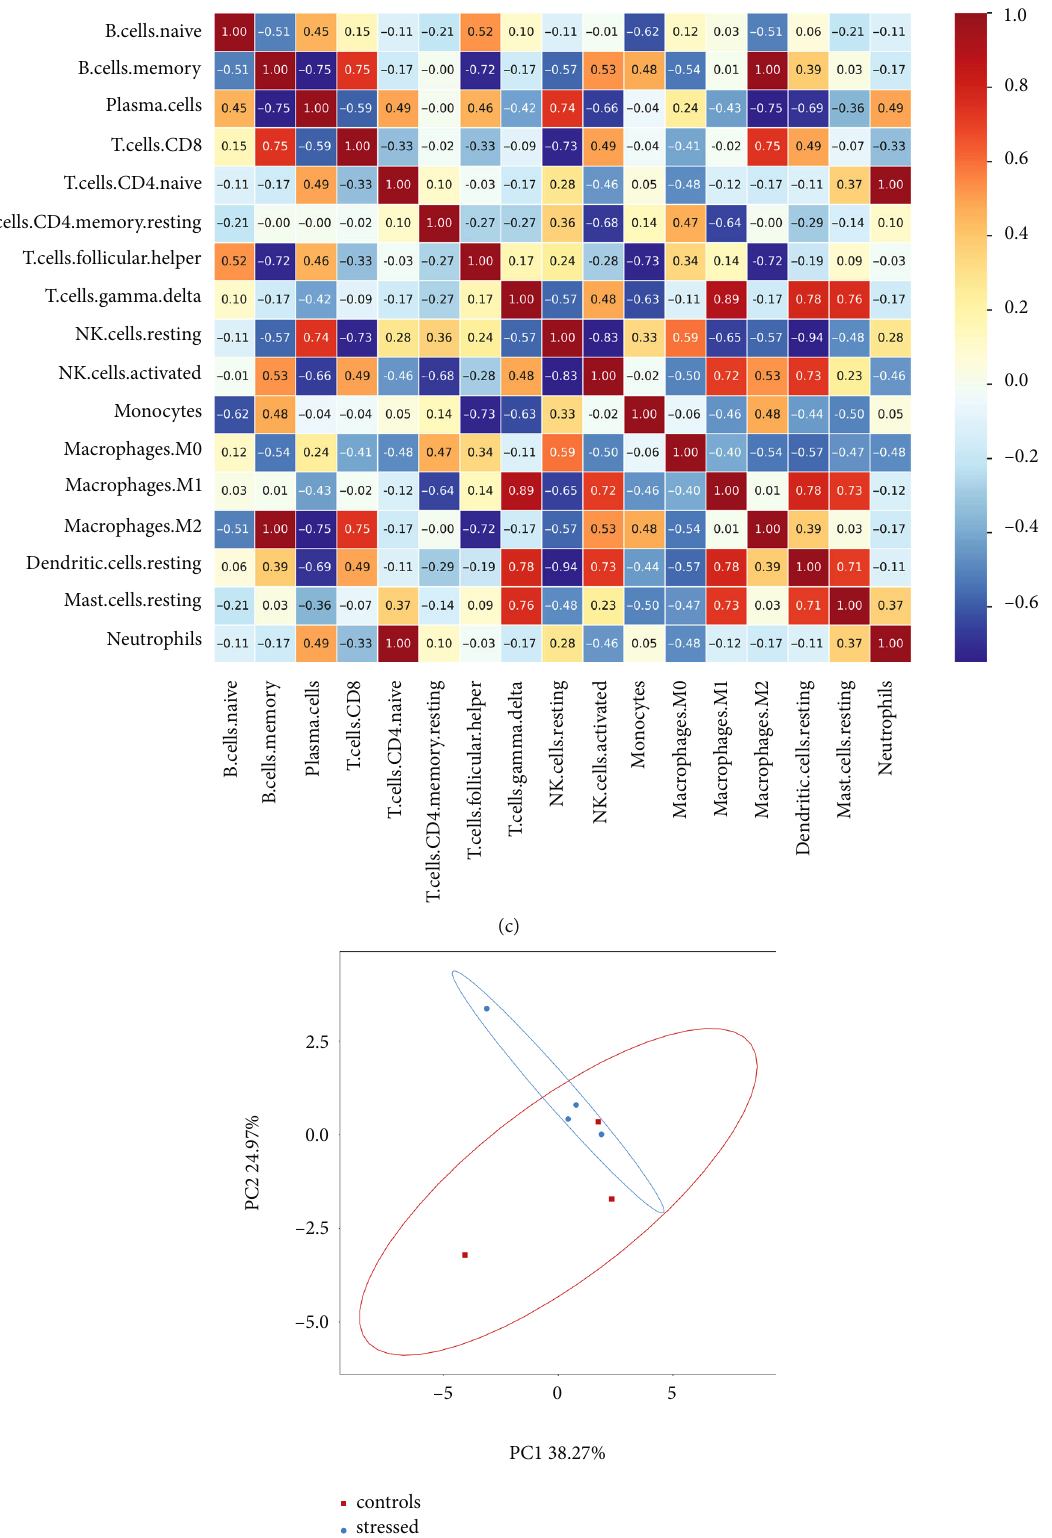
Figure 2: Immune cell in fi ltration analysis in the control and stress groups. (a) Histogram consisting of 22 immune in fi ltrating cells of each sample; (b) di ff erences in immune in fi ltrating cells between the control and stress groups; (c) results of correlation analysis of in fi ltrating immune cells; (d) results of PCA analysis of immune cell in fi ltration in the control and stress